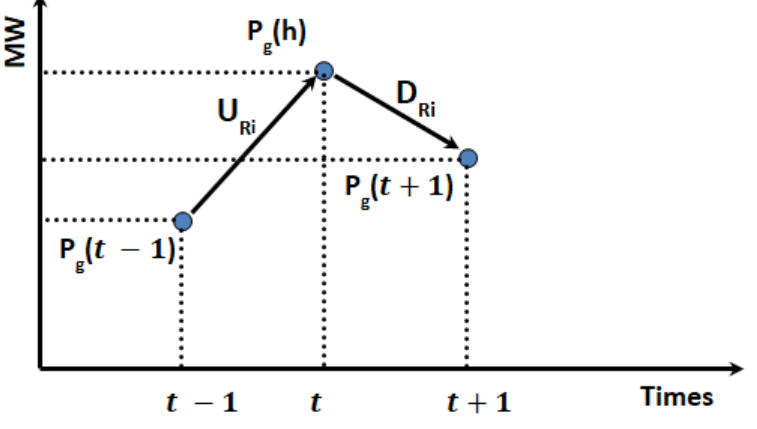
Figure 5. Ramp rate limits of the generating units.